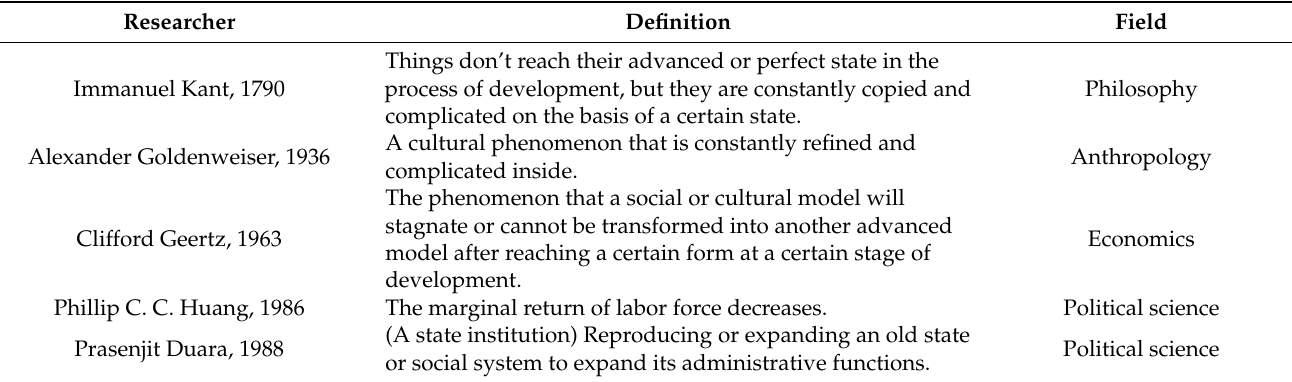
Table 1. Definition of “Involution” in Western academic